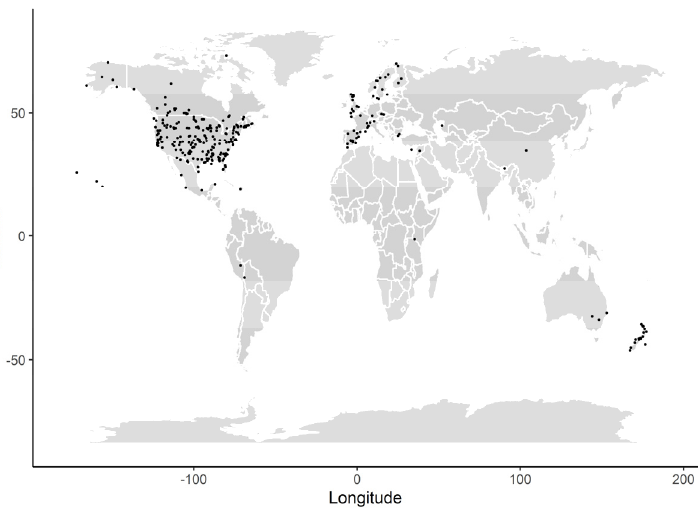
Figure 1. Geographical locations of study sites where predation rates were obtained for different bird species. Locations are shown as black dots. Some locations include more than one predation rate estimate.